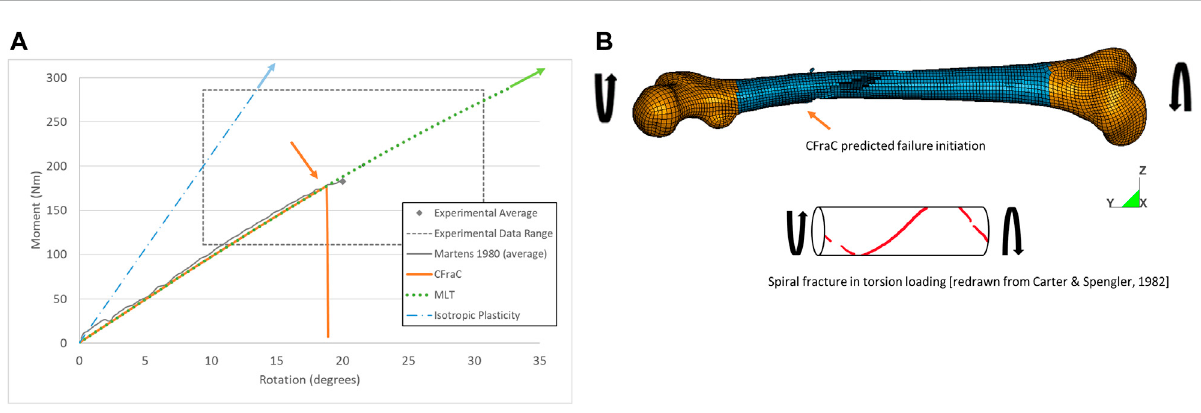
FIGURE 7 Torque-rotation response for whole bone axial torsion test (experimental response from Martens et al., (1980) (A) ; and predicted spiral fracture via eroded elements (B) , fracture initiation location indicated by orange